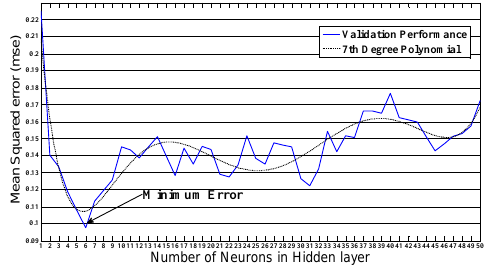
Fig. 9. Mean squared error (mse) as a function of hidden neurons